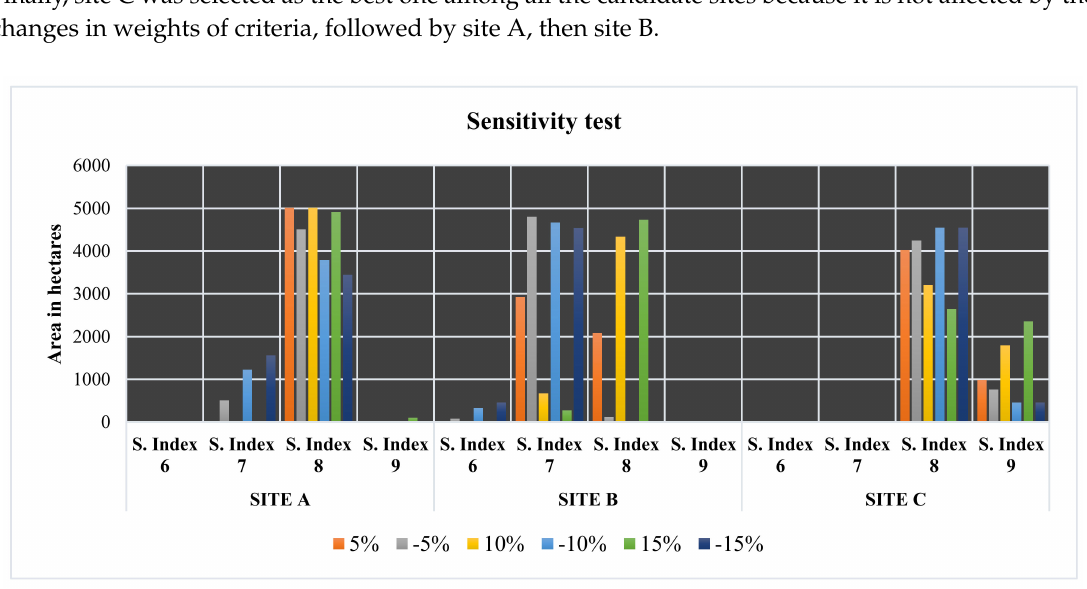
Figure 15. Distribution of suitability index resulting from sensitivity